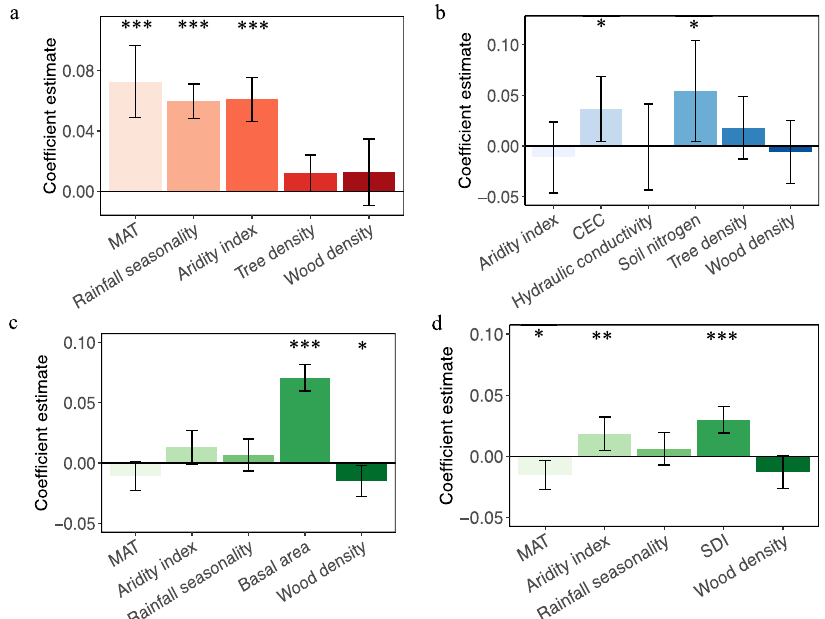
Fig. 3 Standardized response coef fi cients (mean ± 95% CIs) between LOSS and dominant environmental drivers. The scales analyzed were at continents a , tropical regions b vs non-tropical regions c , d . The response coef fi cients were quanti fi ed by linear mixed model which account for each plot as a random effect. Panels c and d used basal area and stand density index (SDI) as competition index, respectively. SDI was de fi ned as the degree of crowding within stocked areas and quanti fi ed as a function of tree density and the quadratic mean diameter in centimeters. Basal area is strongly correlated with total biomass and higher LOSS in higher basal area may be merely because of its correlations. Thus, we used another competition metrics – SDI to further con fi rm the role of competition in LOSS. The error bars denote the 95% con fi dence interval. * P < 0.05; ** P < 0.01; *** P <